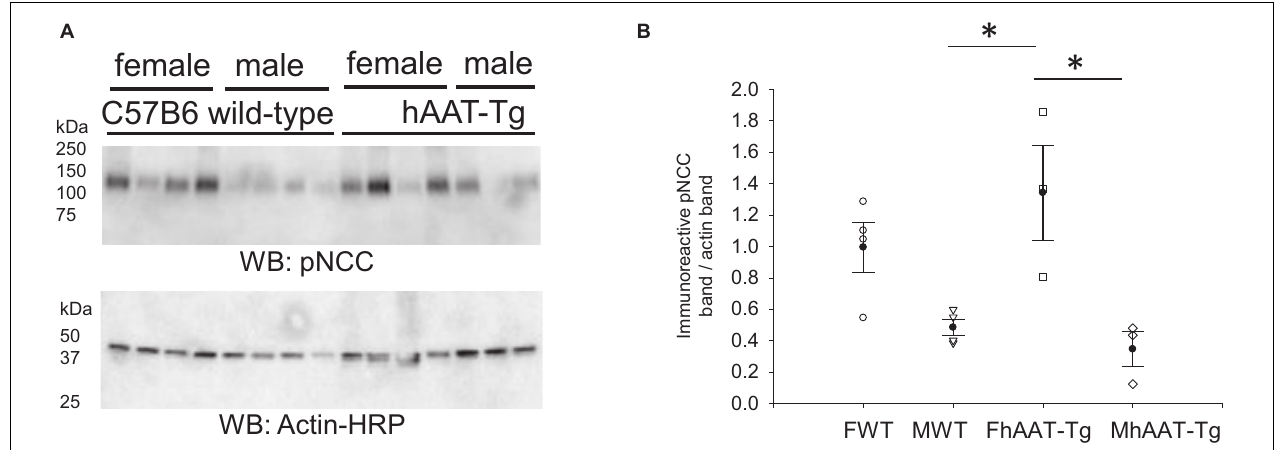
FIGURE 5 | Western blot analysis of phospho-NCC protein expression from the membrane fraction of kidney cortex lysates. (A) Western blot analysis of the alpha subunit of the active membrane bound form of phosphorylated sodium chloride cotransporter (pNCC) protein expression from the membrane fraction of kidney cortex lysates harvested from female and male hAAT-Tg mice and C57B/6 wild-type mice after being maintained initially on a normal salt diet and then a high salt diet and euthanized in the AM. N = 7 hAAT-Tg (4 female and 3 male) and N = 8 C57B/6 (4 female and 4 male) mice. (B) Densitometric analysis of the immunoreactive pNCC bands in panel (A) normalized to actin. Lane 11 of the pNCC blot and the corresponding actin blot was omitted from the analysis. These results were analyzed using a One-Way ANOVA followed by a Holm-Sidak comparison. We used a significance level of * p < 0.05.